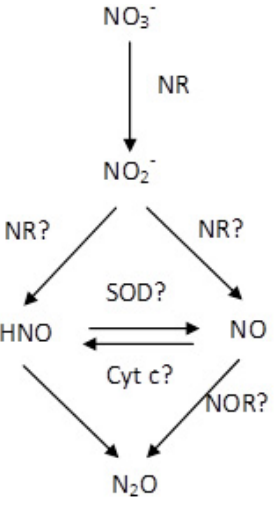
Fig. 6. Putative pathways of N 2 O formation in C. vul- = nitrate, NO − = nitrite, NO = nitric oxide, garis (NO − 3 2 HNO = nytroxyl, NR = nitrate reductase, SOD = superoxide dismutase, NOR = NO reductase, Cyt c = cytochrome c oxidase).